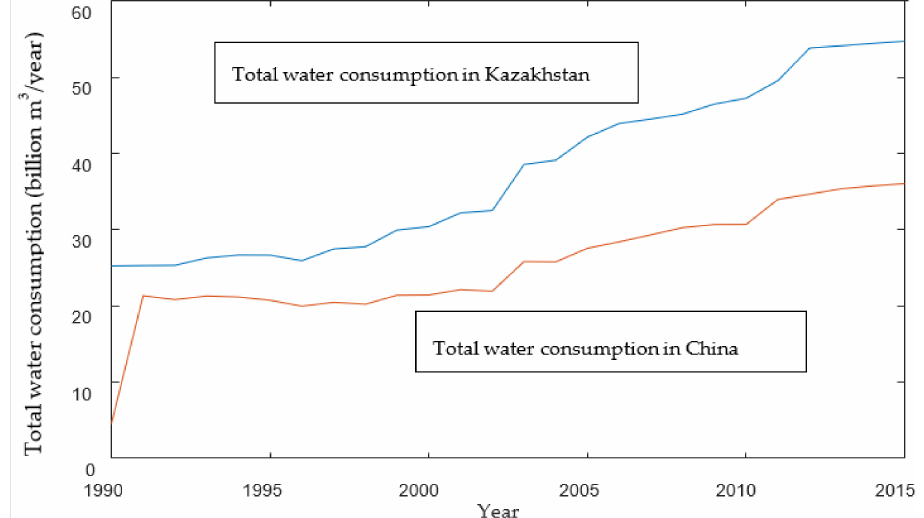
Figure 4. Total water consumption in the study area without virtual water